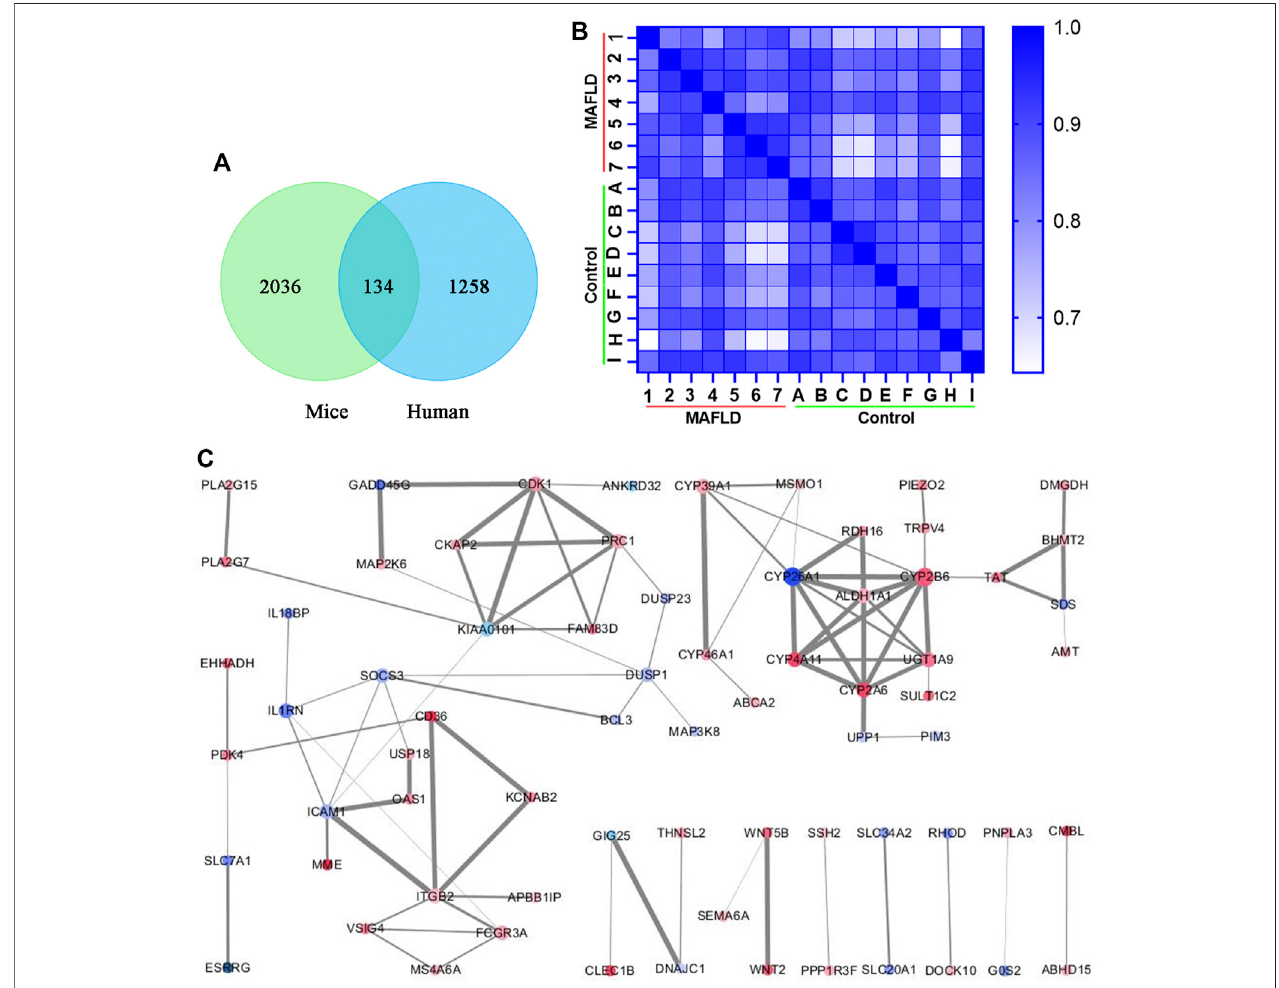
FIGURE3| Overlappinggenesthatappearedintwogroupsofdifferentiallyexpressedgenes. (A) Venndiagramofgenesthatappearinbothgroupsofdifferentially expressed genes. (B) Heatmap of overlapping genes from the transcriptomic analysis was compared with liver tissues of seven patients with MAFLD and nine normal controls. The lighter the color, the smaller the Pearson ’ scorrelation coef fi cient. (C) PPI network from the Cytoscape network analysis of the overlapping genes. The size of the dot represents the number of related protein interactions, the thickness of the line represents the strength of the interaction between proteins. A darker red dot color represents the greater upregulation of gene expression, and a darker blue color represents a greater downregulation of gene expression.